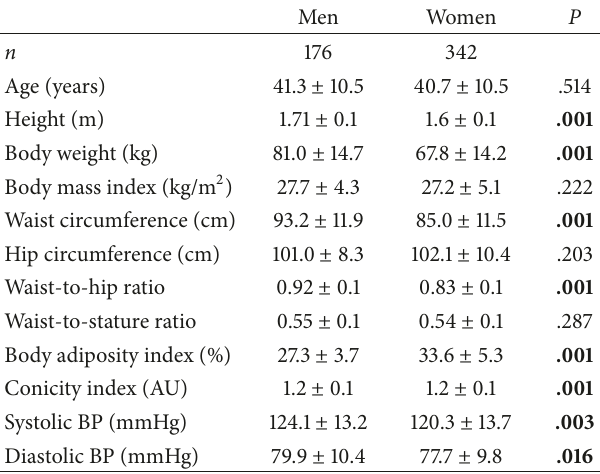
Table 1: Descriptive values and comparison between genders (mean ±